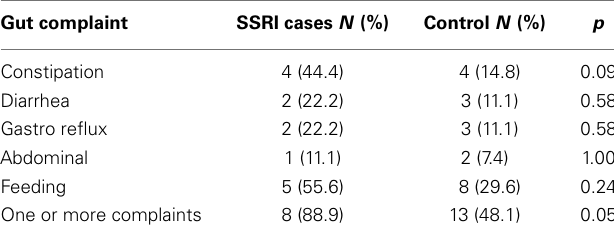
Table 3 | Study 1: chi-square analyses using Fisher’s exact test for both groups of children for the five gastrointestinal